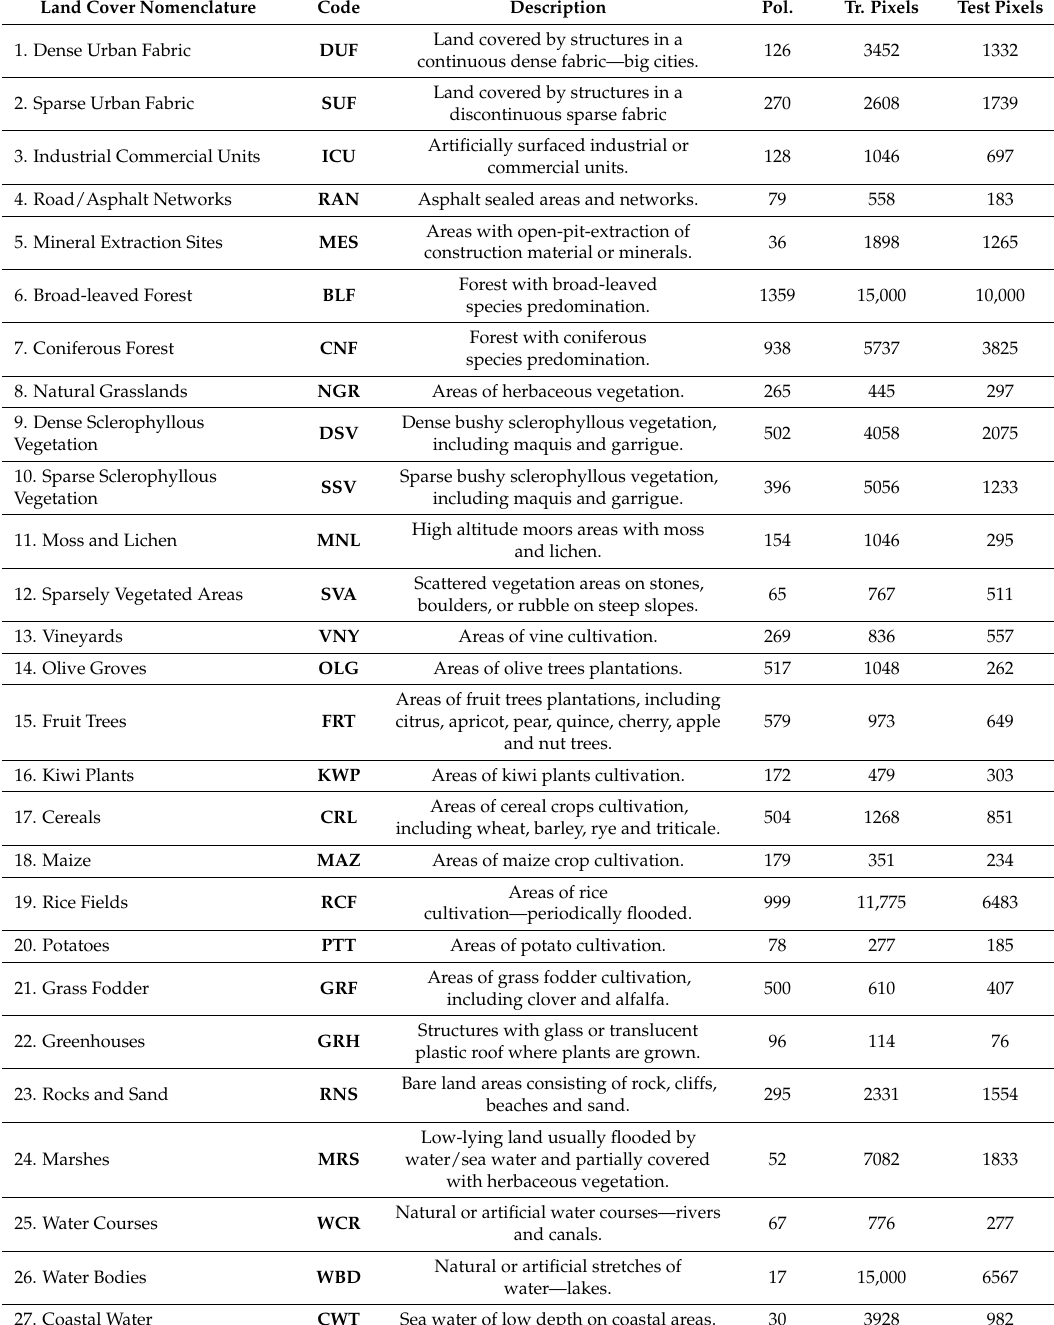
Table 2. The detailed land cover nomenclature with 27 classes. The number of available polygons and pixels used for training and testing are presented for every